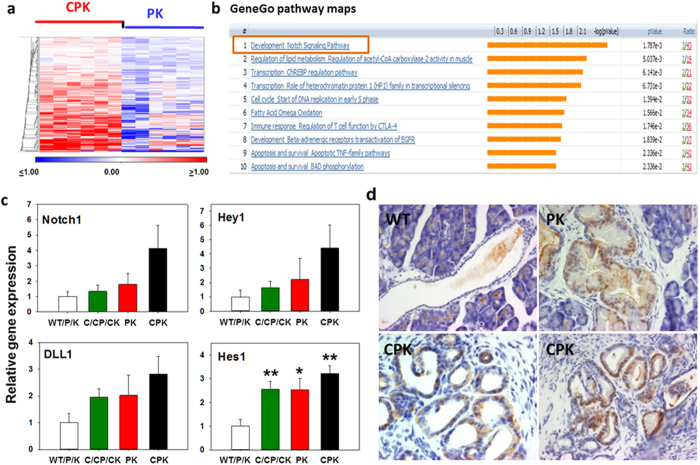
Differential transcriptomes of laser capture microdissected mPanIN-like lesions of PK and CPK mice: Validation of differentially expressed Notch1 signaling in CPK.(a)
In vivo expression profile of laser capture microdissected from mPanIN-like lesions of PK and CPK mice (n = 6, each). The heat map represents genes from 2 class t-test p ≤ 0.005 (without multiple testing correction), 191 transcripts with significant upregulation in CPK vs PK were selected. Each row represents log2 expression ratios of an individual gene and each column indicates an individual sample. Expression ratios are colored according to the scale bar: blue >2-fold downregulation, red >2-fold upregulation. (b) Top 10 functional processes affected by COX-2 overexpression in the PK genetic background. Data analysis among upregulated genes from the 3 months-old CPK and PK gene expression sets resulted in significant enrichment for gene ontology processes related to Notch signaling in development, regulation of lipid metabolism, immune response, cell cycle, survival and apoptosis. (c) Relative gene expression levels of Notch1, Hey1, DLL1, and Hes1 in pancreata of control WT/P/K mice (n = 3) compared to C/CP/CK (n = 3), PK (n = 5) and CPK (n = 5) mice as measured by qRT-PCR. COX-1 amplicons served for normalization. Data is given as mean  ±  SEM. Statistical significance (*p ≤ 0.05, **p ≤ 0.01) was evaluated by Student’s t-test. (d) Expression of Hes1 in pancreata of WT, PK, and CPK mice as detected by immunohistochemistry using anti-Hes-1 antibodies. Note unspecific signals in WT tissue, while nuclear Hes1 signals were observed in TC and mPanIN-like lesions of PK and CPK specimens. Nuclei are stained with hematoxylin. Magnifications: 40x (WT), 63x (PK, CPK).